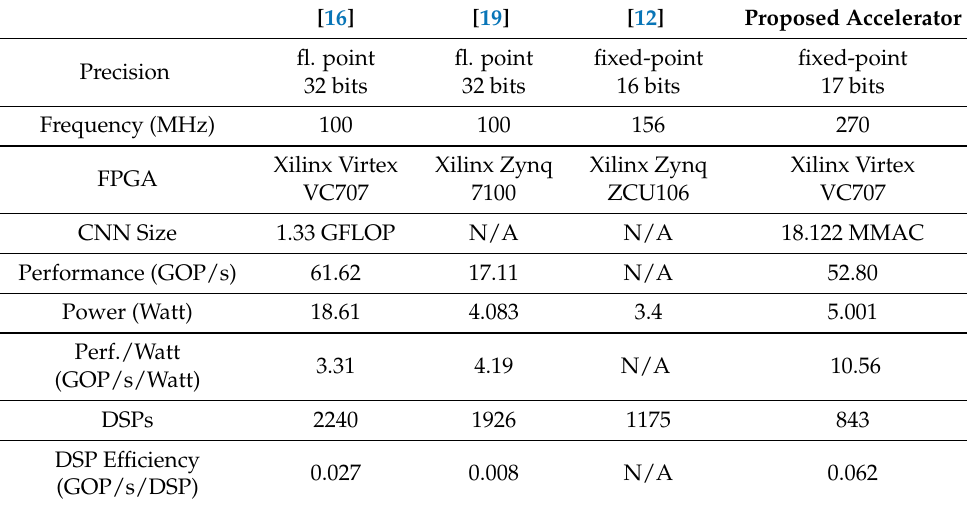
Table 4. Reporting the features of related